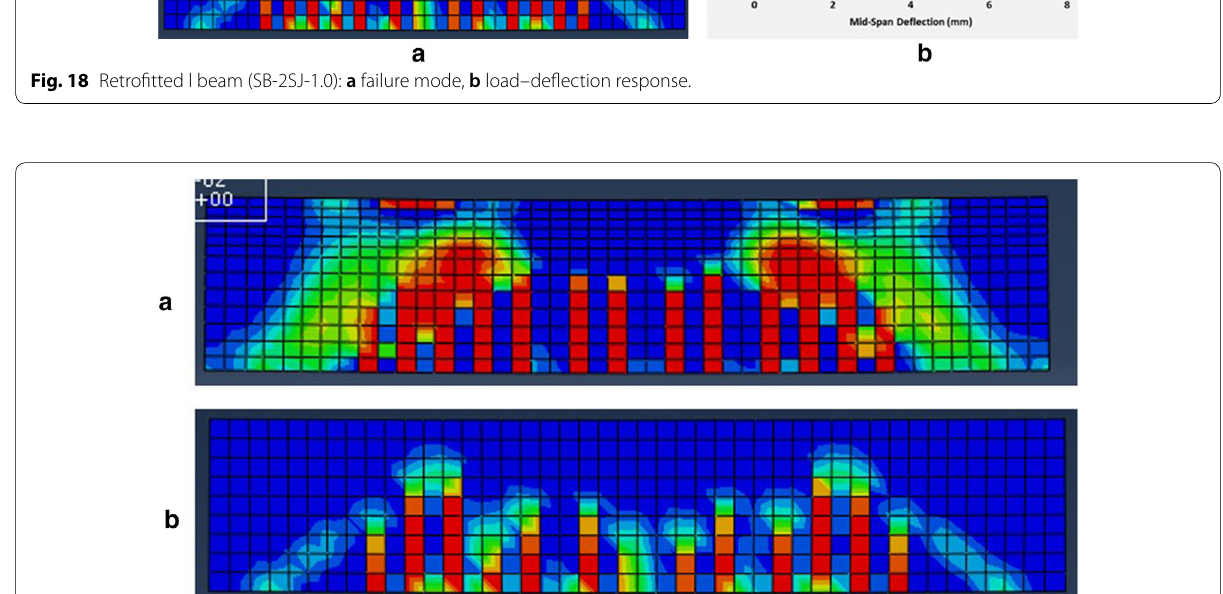
Fig. 19 Retrofitted beam (SB‑2SJ‑1.0): a interfacial surface of NC—shear failure, b flexural failure at retrofitted